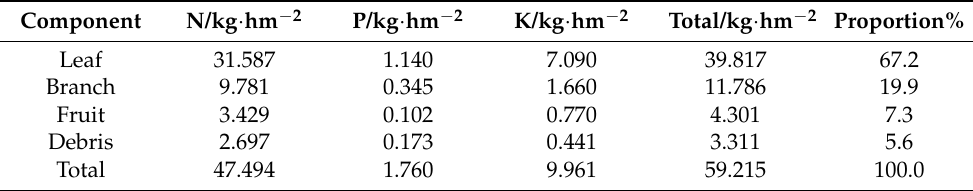
Table 8. Annual return of litter nutrients in Liquidambar formosana plantations.